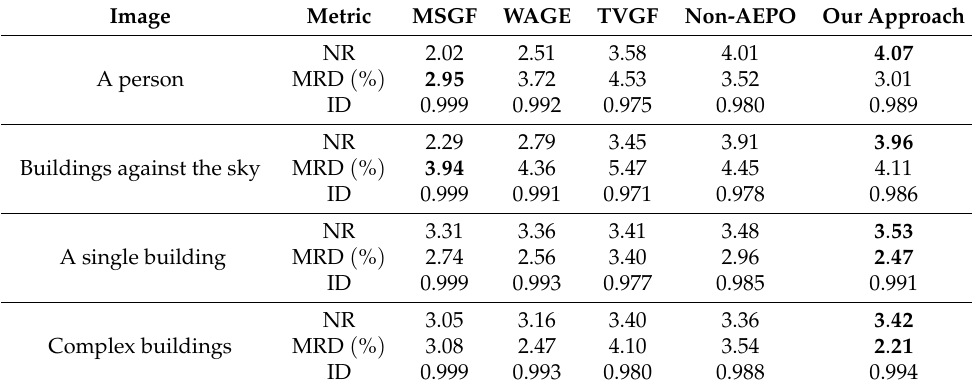
Table 1. Metrics of different methods on different